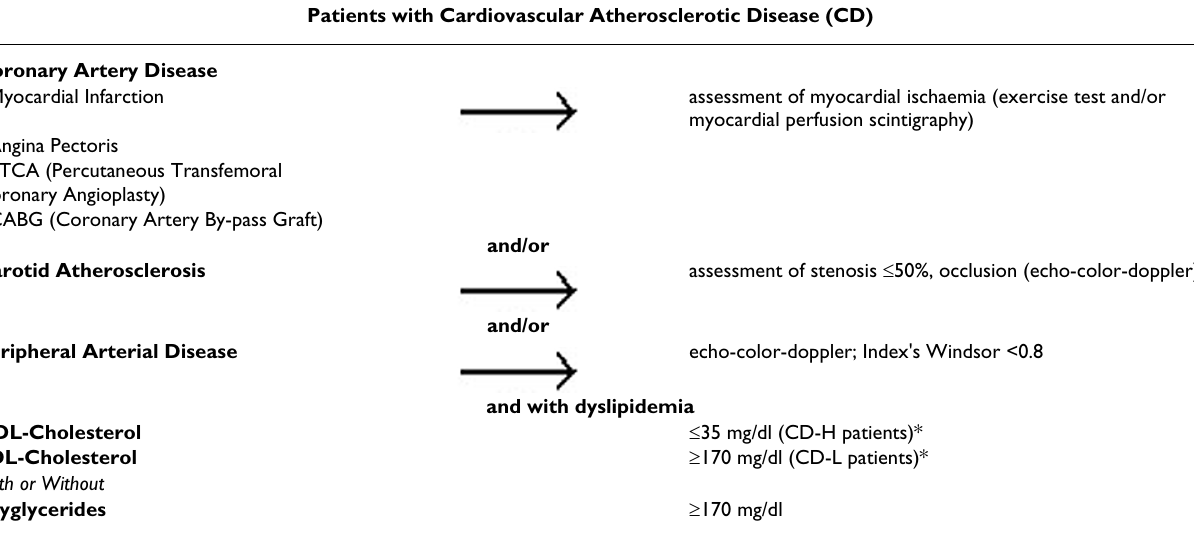
Table 1: Diagnostic criteria used to identify CD-H and CD-L patients with Cardiovascular Atherosclerotic Disease (CD) Patients with Cardiovascular Atherosclerotic Disease (CD)